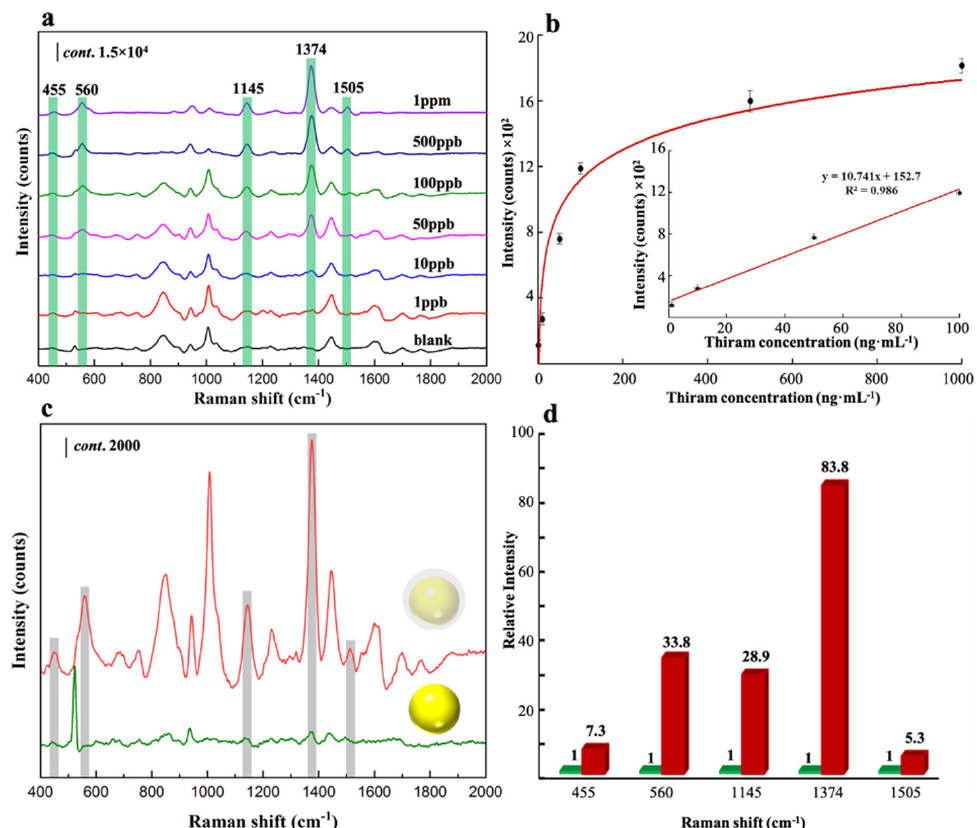
Figure 3. ( a ) Thiram concentration-dependent SERS spectra; ( b ) plot of Raman intensity (I 1374 ) as a function of thiram concentration from 1 to 1000 ng · mL − 1 . The inset shows the linear response for thiram range of 1 to 100 ng · mL − 1 ; ( c ) SERS spectra of thiram in the presence of Au NP and Au@BUT-17; ( d ) the relative Raman intensity of characteristic peaks located at 455 cm − 1 , 560 cm − 1 , 1145 cm − 1 , 1374 cm − 1 and 1505 cm − 1 .